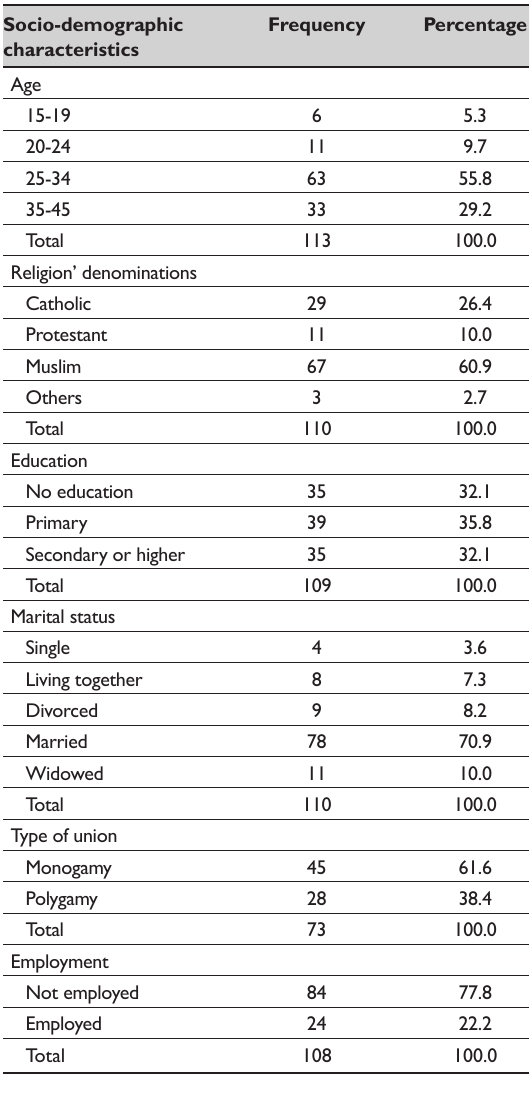
Table 1: Background characteristics of mothers Socio-demographic